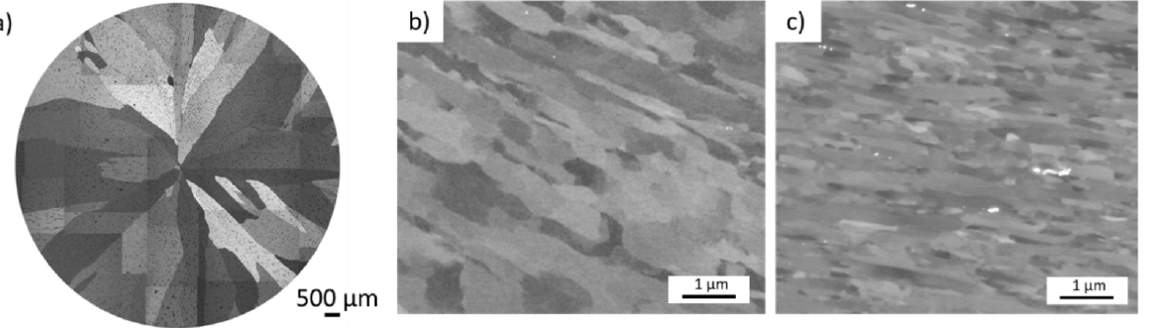
Figure 4. Orientation image maps taken on the ND ( a , d , g ), PD ( b , e , h ) and RD ( c , f , i ) planes of the sample processed with stationary mandrel. Panels ( a – f ) were colorized according to IPF (see orientation triangle), and panels ( g – i ) were colorized by unique color.